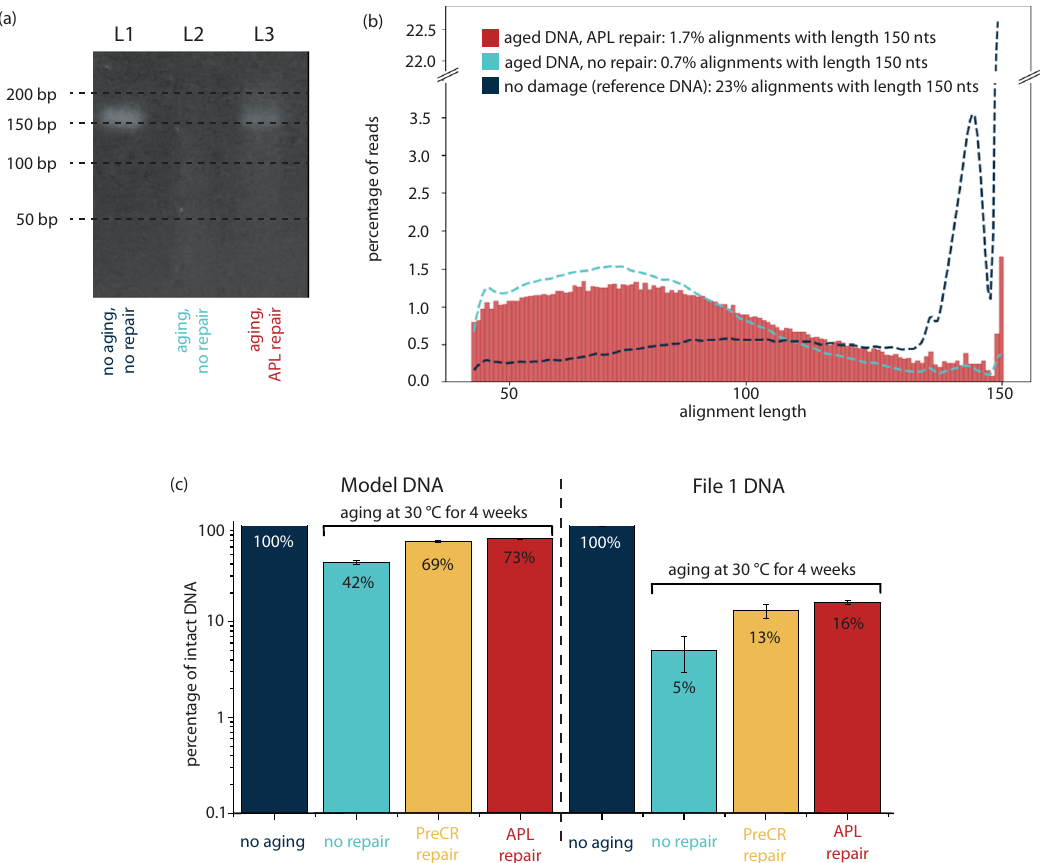
Fig. 4 Enzymatic repair of DNA libraries. a Denaturing gel of fi le 1 DNA aged at 30 °C for 4 weeks. Bands show reference DNA (no aging, no repair), damaged DNA without repair (aging, no repair) and damaged DNA that has been treated with APL repair (aging, APL repair). b Fragmentation of fi le 1 DNA after alignment comparing reference and aged DNA to APL repaired DNA. c Repair potential of commercial enzymatic repair mix (PreCR repair) and self- composed enzymatic repair mix (APL repair) shown for damaged fi les aged at 30 °C for 4 weeks. Data is shown on a log scale due to the exponential nature of qPCR; s.d. from three qPCR